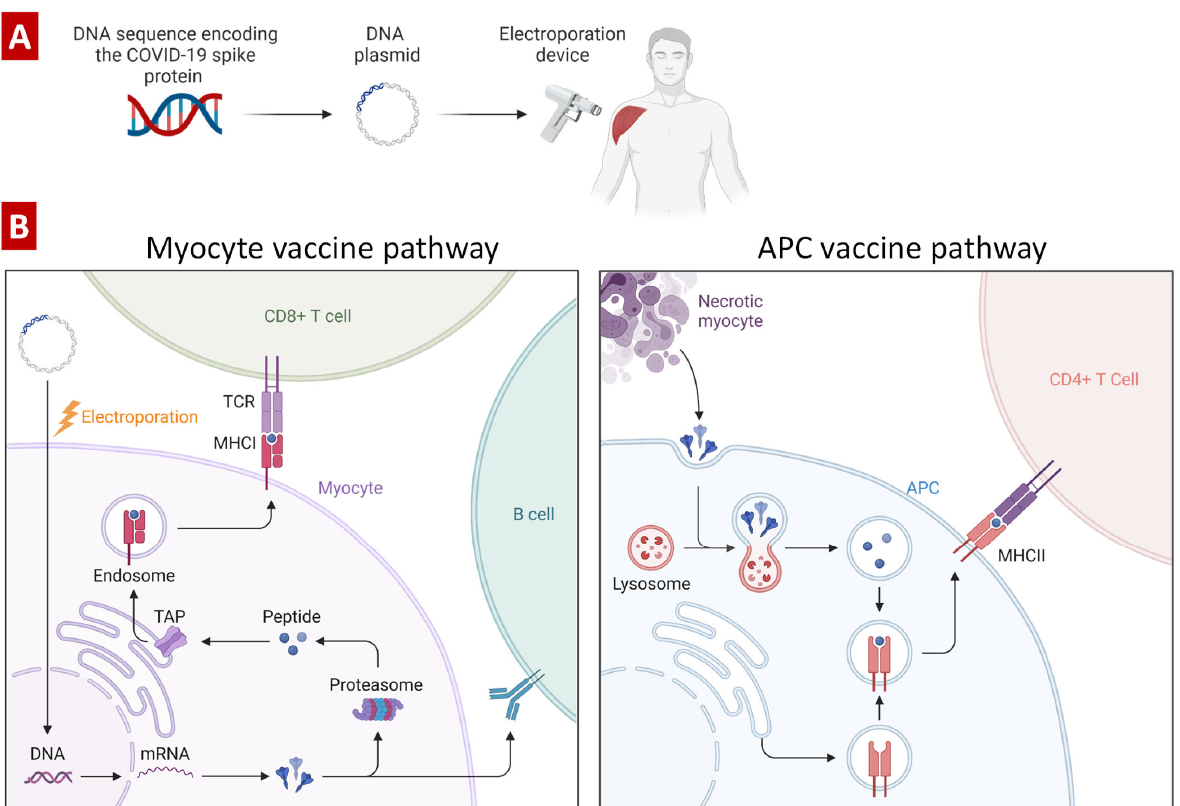
Figure 12. Two main types of DNA-based COVID-19 vaccines. ( A ) Intramuscular injection of pDNA encoding CoV spike protein using an electroporation device to promote its uptake by the cells near the injection. ( B ) Mechanisms of action of DNA-based COVID-19 vaccines. The peptides are transported to the endoplasmic reticulum with transport-associated proteins (TAP1 and TAP2) and subsequently bind to MHC class I molecules. After binding, MHC I is released from the complex and translocated via the Golgi apparatus to the cell surface, where it can be recognized by cytotoxic T cells (CD8+). Modified with permission from [106].